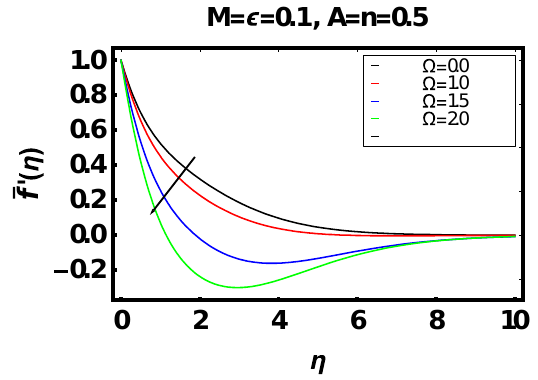
Figure 2. Velocity along 𝑥̅ -direction for variant Ω.